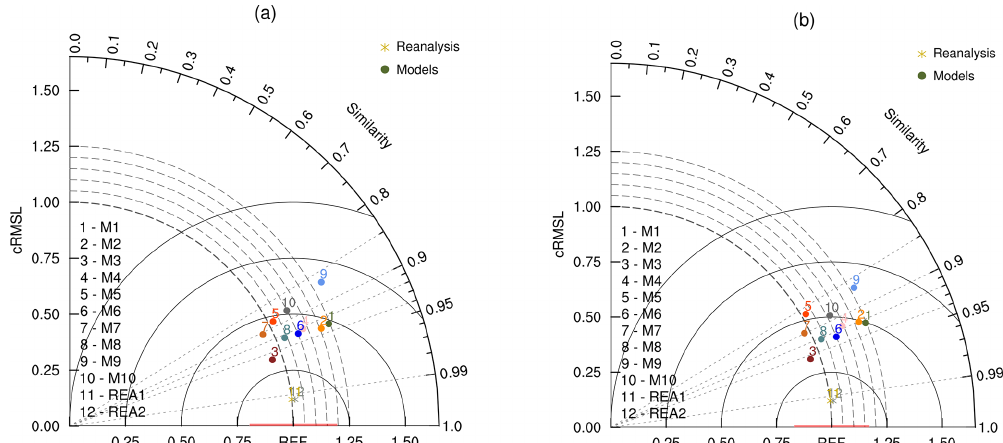
Figure 7. VFE diagram. This describes the climatological mean autumn (September–October–November) 850hPa wind fields derived from the different CMIP5 models (M1–M10) in the Northern Hemisphere. The azimuthal position gives cVSC, the radial distance from the origin indicates cRMSL, and the distance between the model and the reference points provides cRMSVD. The cRMSL and the cRMSVD are normalized by the cRMSL derived from the mean of two reanalysis datasets (REA1, REA2). The area weighting is considered in the statistical metrics in panel (a) but not in (b) . The observational uncertainty is indicated by the horizontal red line centered at the REF point. Here, we use M SD value derived from REA1 and REA2 to estimate observational